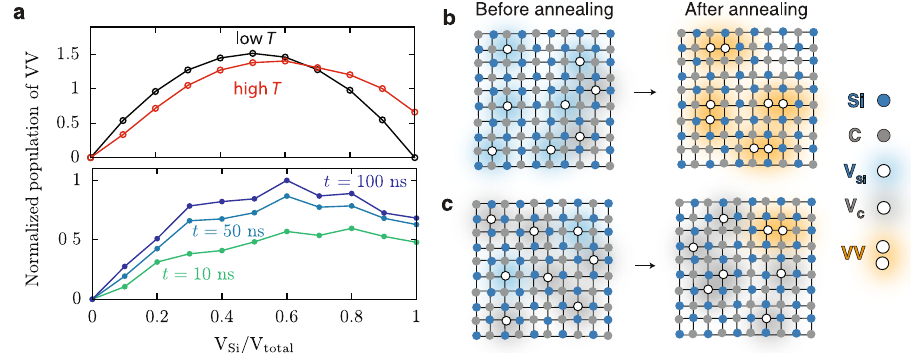
Fig. 5 Dependence of VV-conversion ef fi ciency on the initial composition of monovacancies. a (top panel) KMC simulations showing changes in the long-time limit of VV population starting with varying concentrations of V Si , i.e., the number of V Si over the total number of vacancies, at two different temperatures T (black line at T KMC = 1500 K, red line at T KMC = 2000K). (bottom panel) Classical MD simulations showing the time evolution of mono- to divacancy conversion up to 100 ns at T MD = 1500 K, starting with different fractions of V Si , i.e., the number of V Si over the total number of V Si and V C . The VV formation favors higher concentrations of V Si , agreeing with the high-temperature behavior of the KMC model. b – c Schematics for controlling divacancy formation by tuning the V Si -to-V C ratio during thermal annealing at high temperature based on the results from panel a . b Samples having a greater number of V Si than V C prior to annealing (left) producing more VV after annealing (right). c Samples having a fewer number of V Si than V C prior to annealing (left), producing fewer VV after annealing (right).